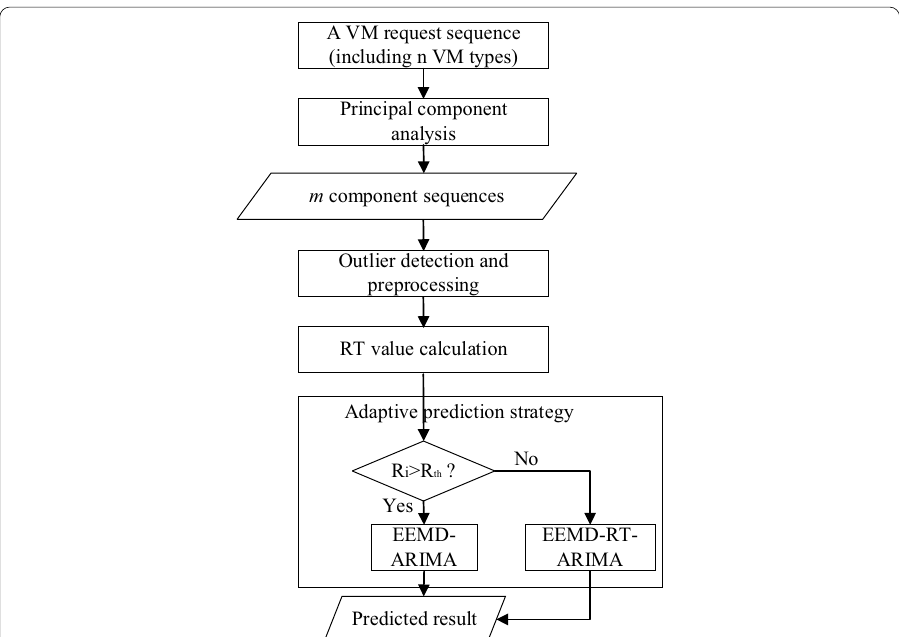
Fig. 2 RT-based adaptive prediction method. The m component sequences are extracted from a VM request sequence using the principal component analysis method. Next, these component sequences are detected to find and preprocess the outliers. Then, the RT values of these preprocessed sequences are calculated. Finally, these sequences are predicted by adaptively selecting the EEMD-ARIMA or EEMD-RT-ARIMA method according to the comparison between their RT values and the